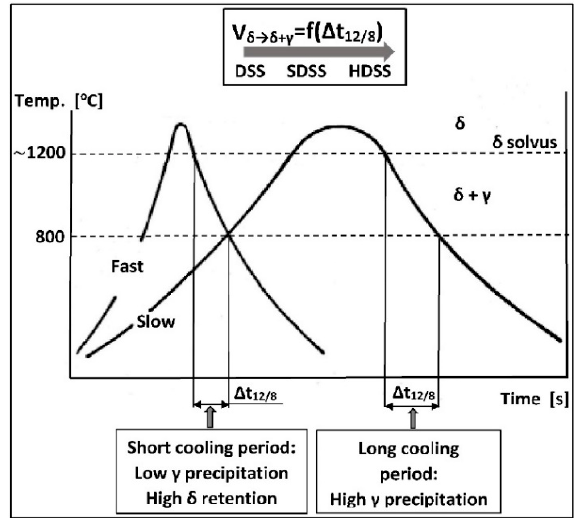
Figure 6. Influence of cooling rate on the content of δ -ferrite in duplex steels (according to [30]). Left-hand frame: fast cooling, high δ -ferrite content; right-hand frame: slow cooling, high content of γ -austenite precipitates.